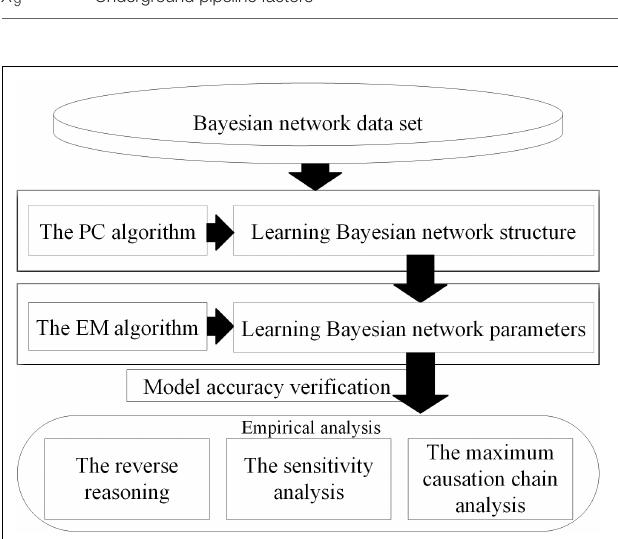
FIGURE 4 | The Bayesian network build